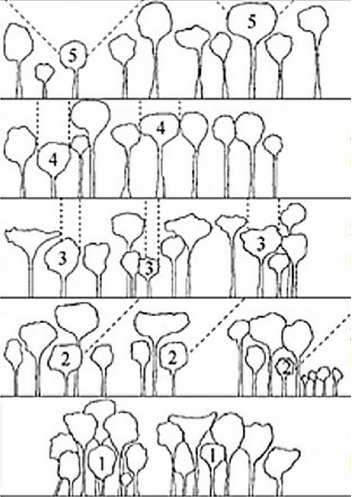
Figure 5. Classification of the Dawkins’ crown illumination index (adapted from Dawkins, 1958): (1) no direct light, (2) low lateral light, (3) some vertical light (10%–90% of the vertical projection of the crown exposed to vertical illumination), (4) crown completely exposed to vertical light but lateral light blocked within some or all of the 90 ◦ inverted cone encompassing the crown, and (5) crown fully exposed to vertical and lateral illumination.